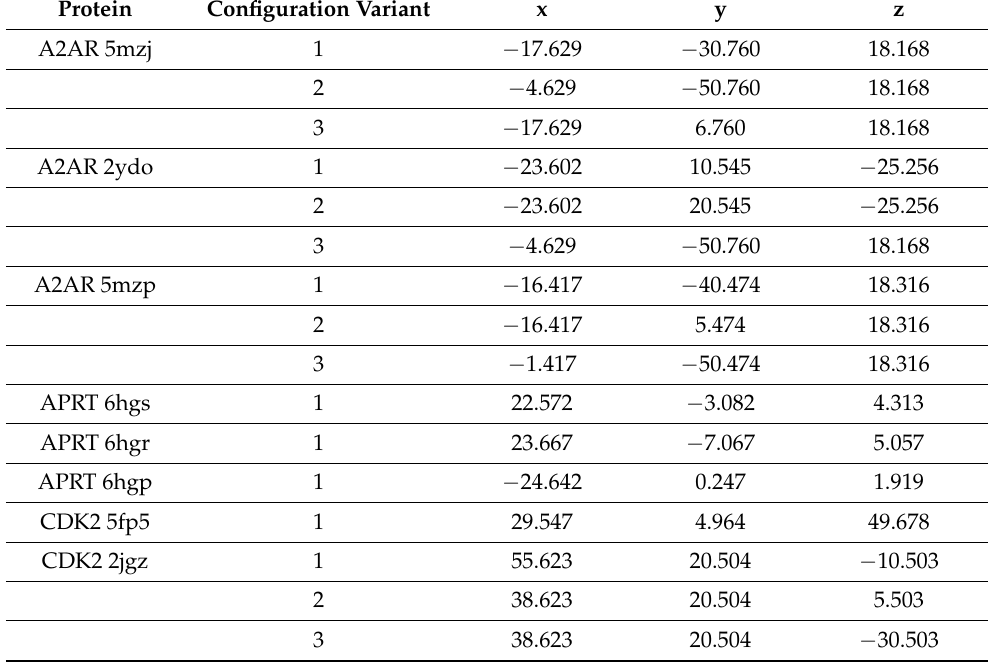
Table 6. Grid centers of the docking experiments.